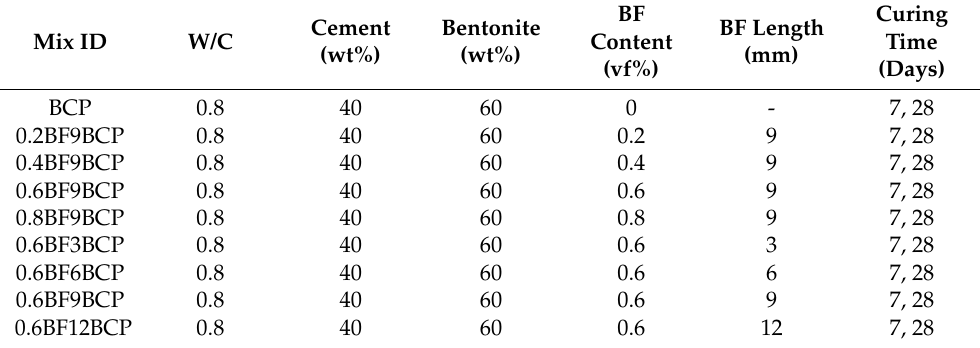
Figure 1. Gradation curve of bentonite and cement.